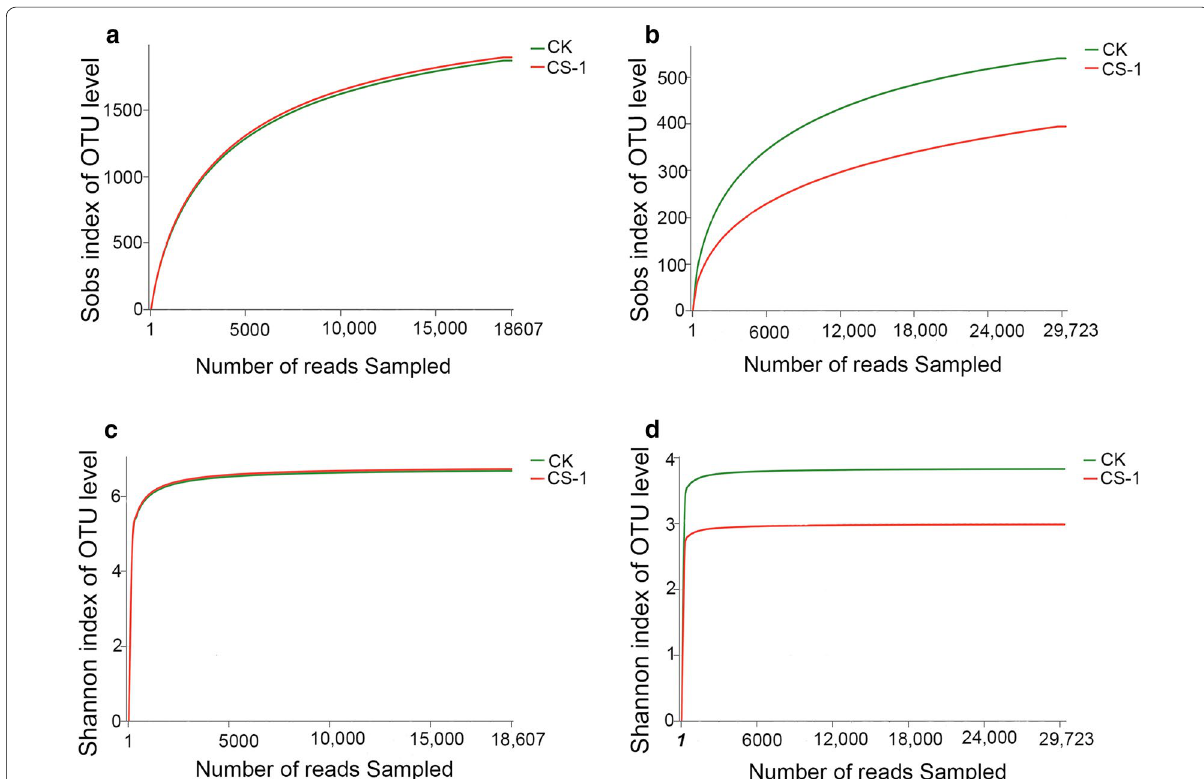
Fig. 3 Rarefaction and Shannon curve of CS-1 and control treatments. Fungal and bacterial rarefaction curves and Shannon curves depicting the effect of CS-1 and control treatments on the number of OTUs. a Rarefaction curves of bacteria from CS-1 and control treatments. b Rarefaction curves of fungi from CS-1 and control treatments. c Shannon curves of bacteria from CS-1 and control treatments. d Shannon curves of fungi from CS-1 and control